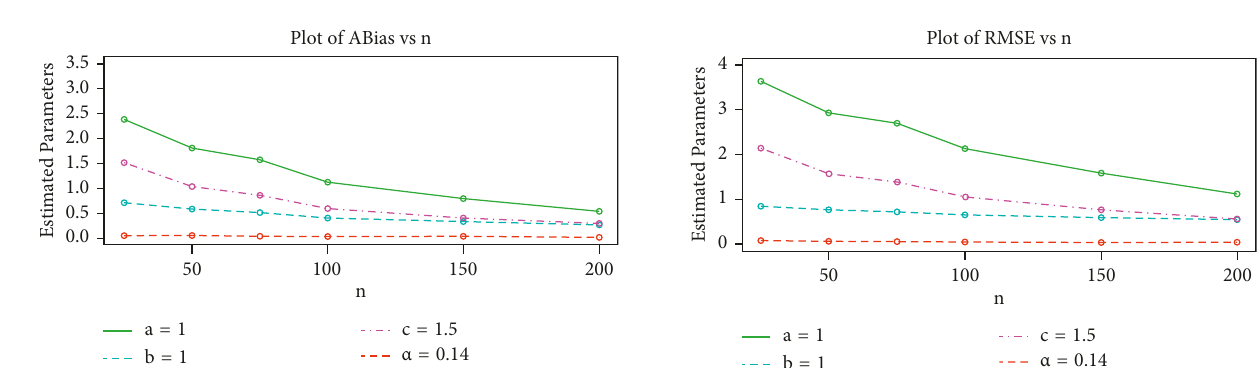
Figure 7: The plots of RMSEs for the ExEW parameters in set I.